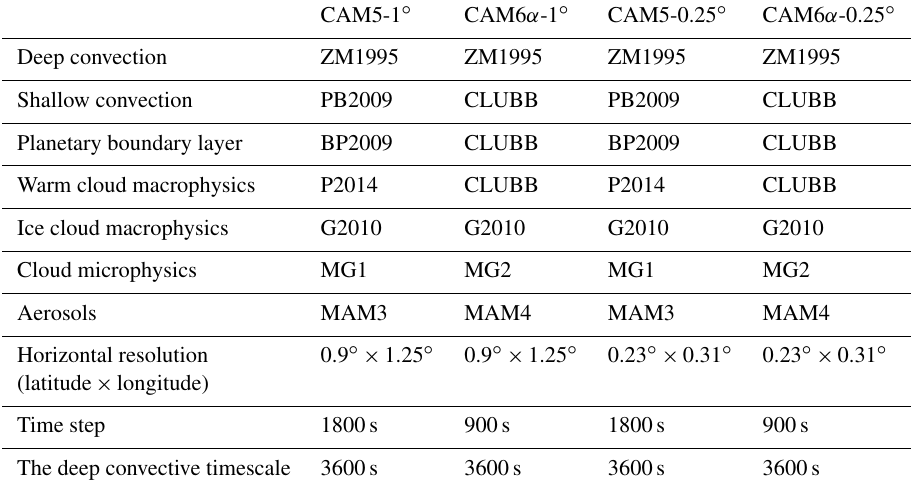
Table 1. Four CAM versions with major physical schemes and the time step listed in abbreviations. ZM1995 is Zhang and McFarlane (1995). PB2009 is Park and Bretherton (2009). BP2009 is Bretherton and Park (2009). P2014 is Park et al. (2014). MG1 is Morrison and Gettelman (2008). MG2 is Gettelman and Morrison (2015). G2010 is Gettelman et al. (2010). CLUBB is Golaz et al. (2002a). MAM3 is Liu et al. (2012). MAM4 is Liu et al. (2016).